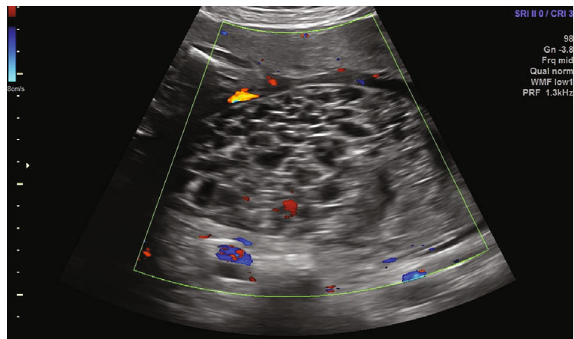
Figure 2: Close of color Doppler of molar